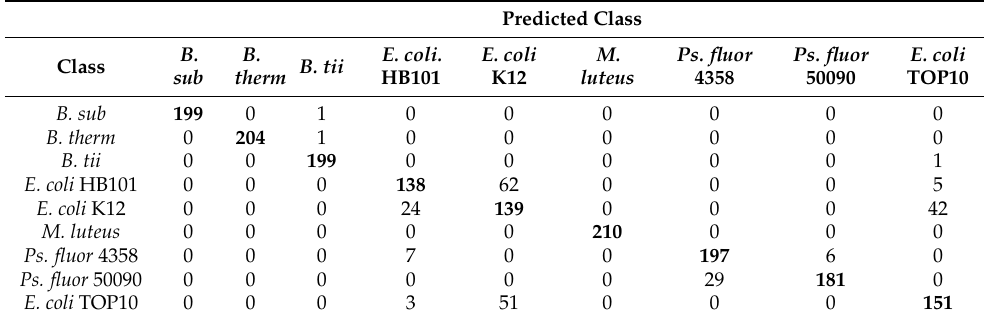
Table 1. Confusion matrix for the independent test data set: Rows represent the observed groups and columns represent the expected groups. The values in the table’s diagonal correspond to the correct grouping of observations.